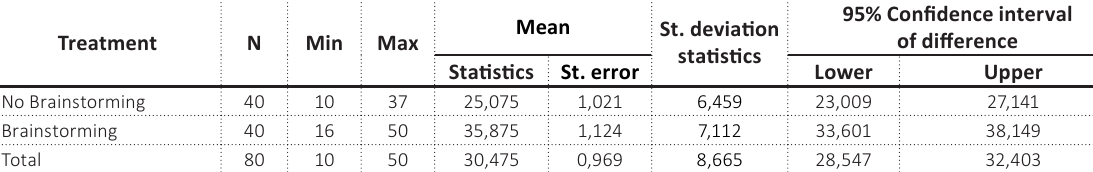
Table 4. Descriptive statistics of the experiment participants’